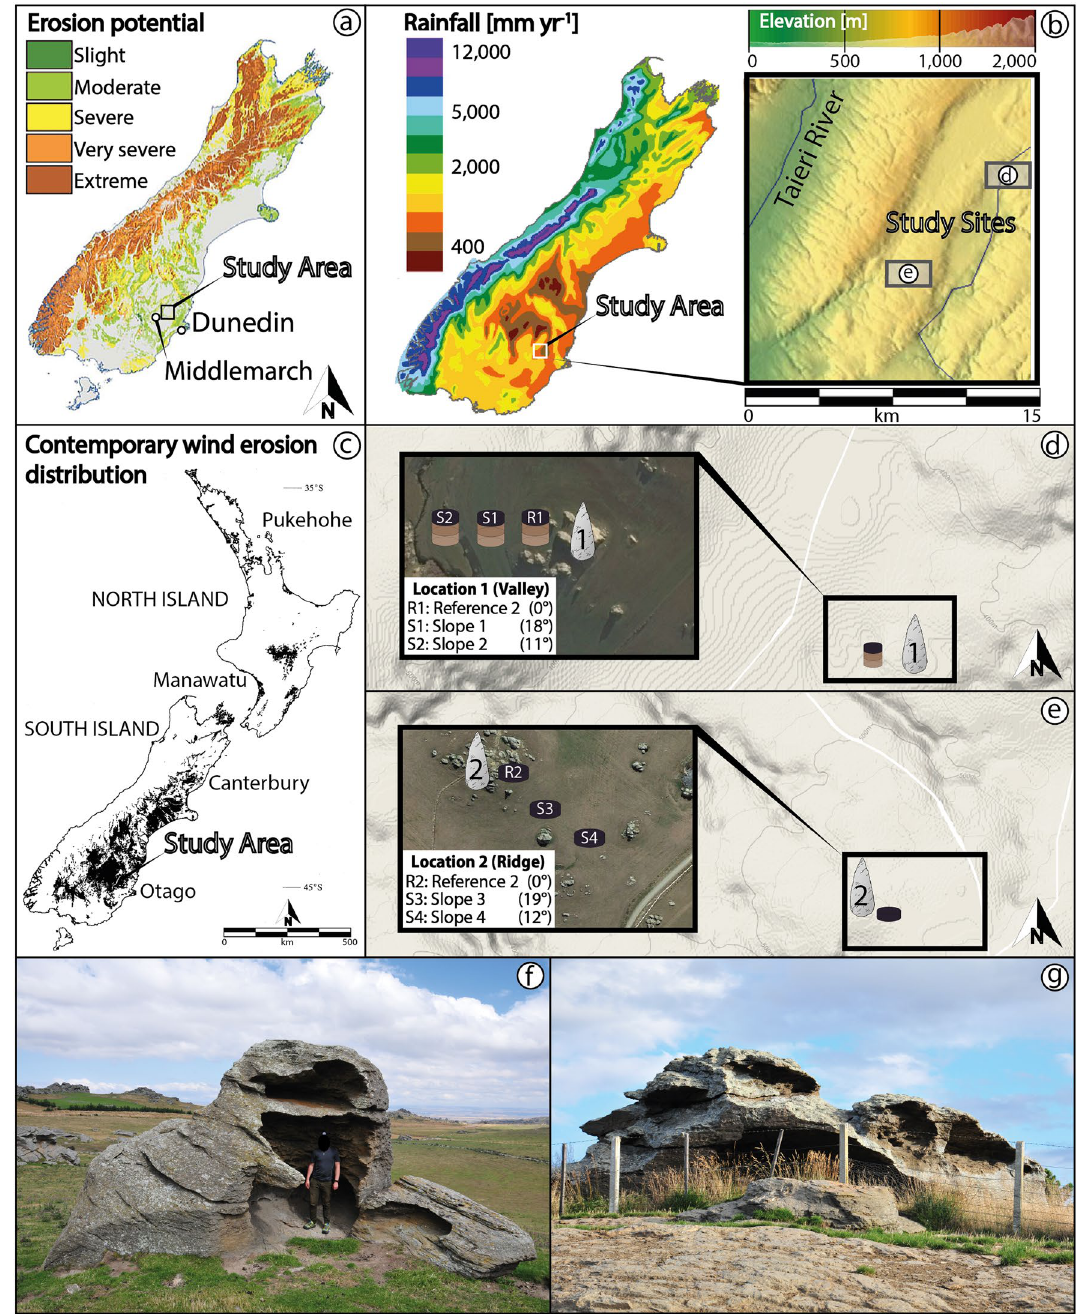
Figure 1. ( a ) Potential soil erosion map of New Zealand ‘s South Island 7 . ( b ) Annual rainfall of New Zealand’s South Island 8 and position of the study area with study site locations. ( c ) Map of the contemporary wind erosion distribution (darkened areas represent the contemporary wind erosion distribution) in New Zealand from the New Zealand Land Resource Inventory 9 . ( d , e ) detailed study site sampling maps (Google Maps and Google Earth, 2019). Both ( f ) and ( g ) are examples of highly weathered and hollowed out local schist tors at the investigated